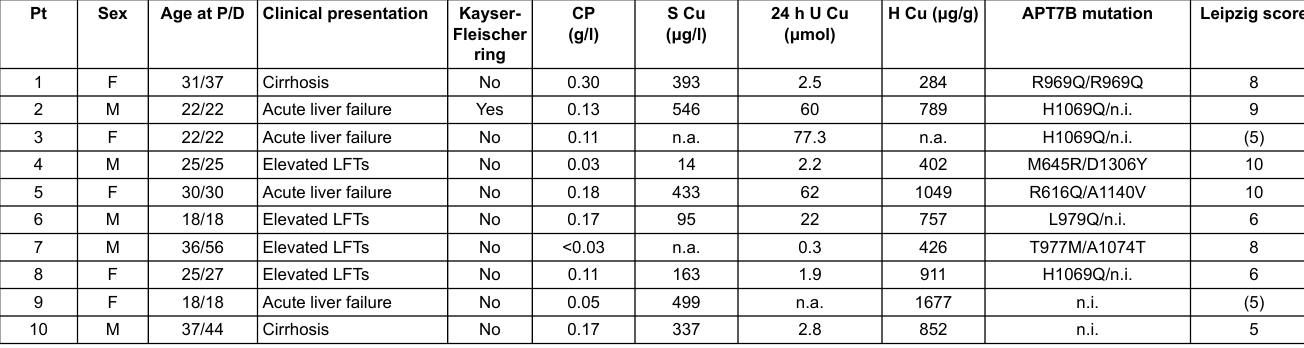
Table 1: Characteristics of patients with Wilson disease. Pt Sex Age at P/D Clinical presentation